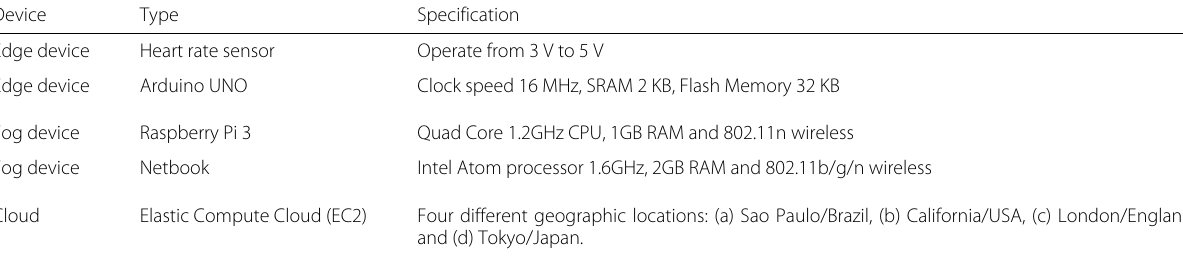
Table 4 Prototype infrastructure components